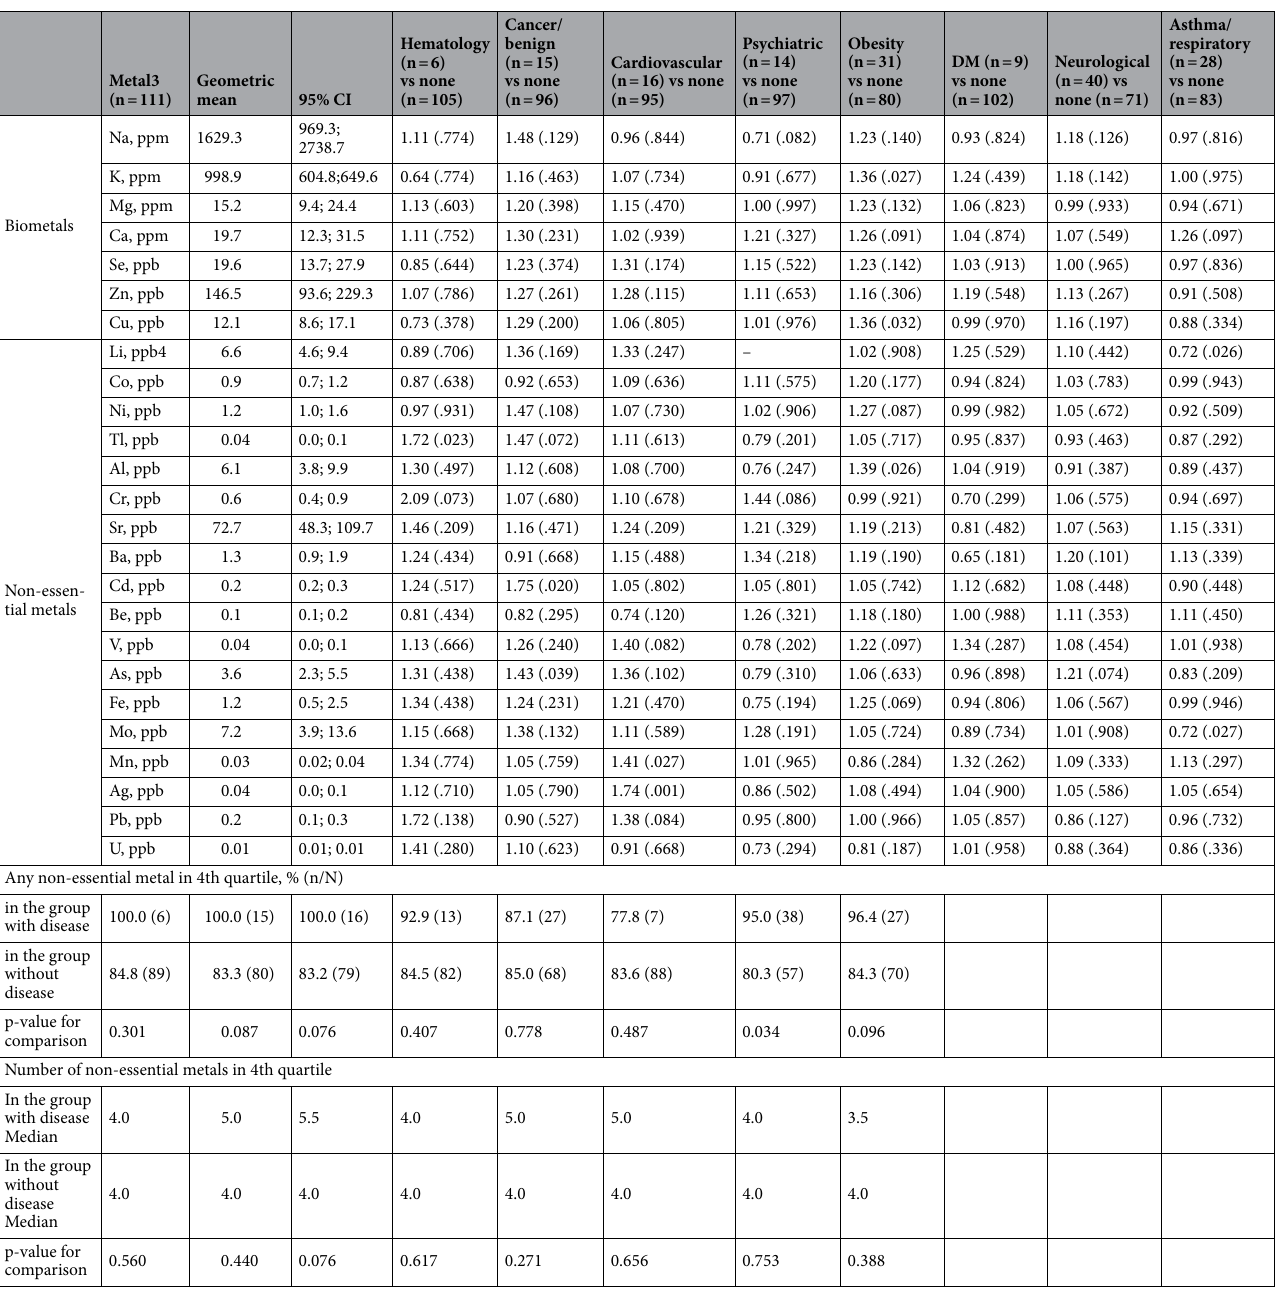
Table 2. Association between internal dose of metals in quartiles and presence of a clinical outcome at follow-up expressed as Prevalence Ratio (PR), ( p -value) 1,2 . 1 The table presents a Prevalence Ratio (PR) reflecting a multiplicative variation in the metals’ concentrations associated with presence of a health outcome, adjusted to age. Age was statistically associated with the cardio-vascular outcome, psychiatric morbidity, obesity and diabetes mellitus. 2 Estimates with p -value < 0.1 are shaded. 3 Li values in subjects with a psychiatric diagnosis were defined as